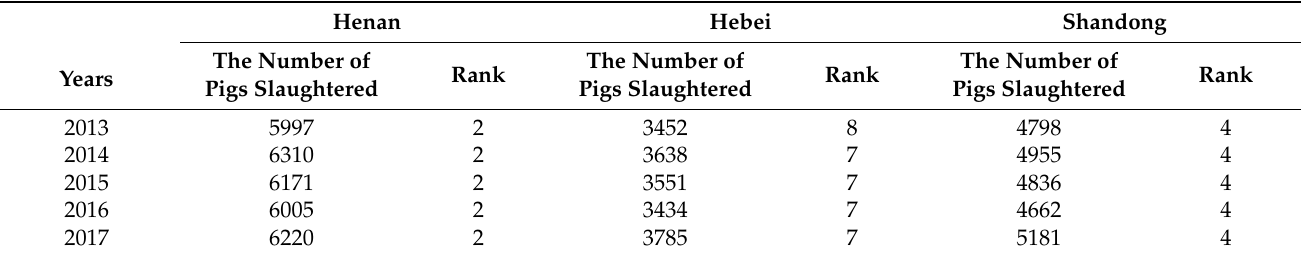
Table 1. The pig breeding ranking of the selected